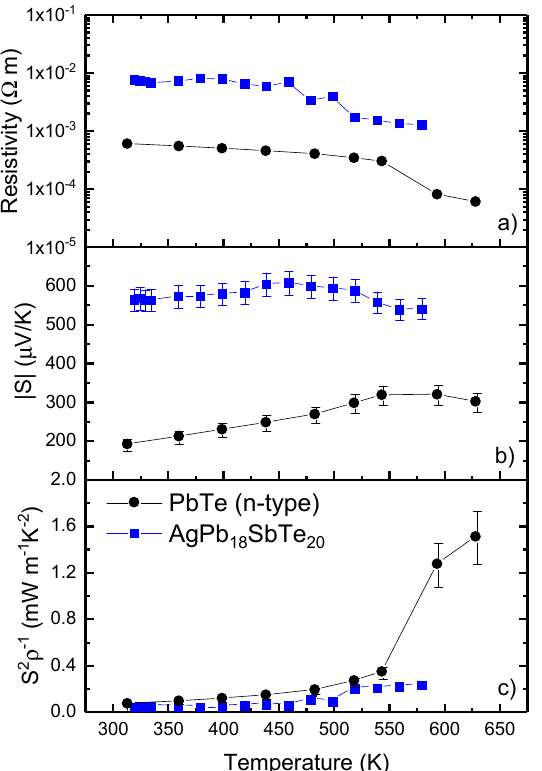
Figure 6. ( a ) Resistivity, ( b ) Seebeck coefficient, and ( c ) power factor above room temperature for PbTe and AgPb 18 SbTe 20 prepared by arc melting.